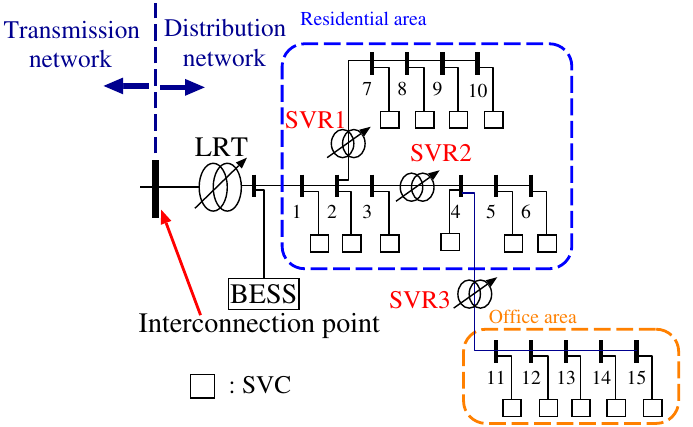
Figure 2. Distribution system model. LRT, load ratio transformer; SVR, step voltage regulator; SVC, static VAR